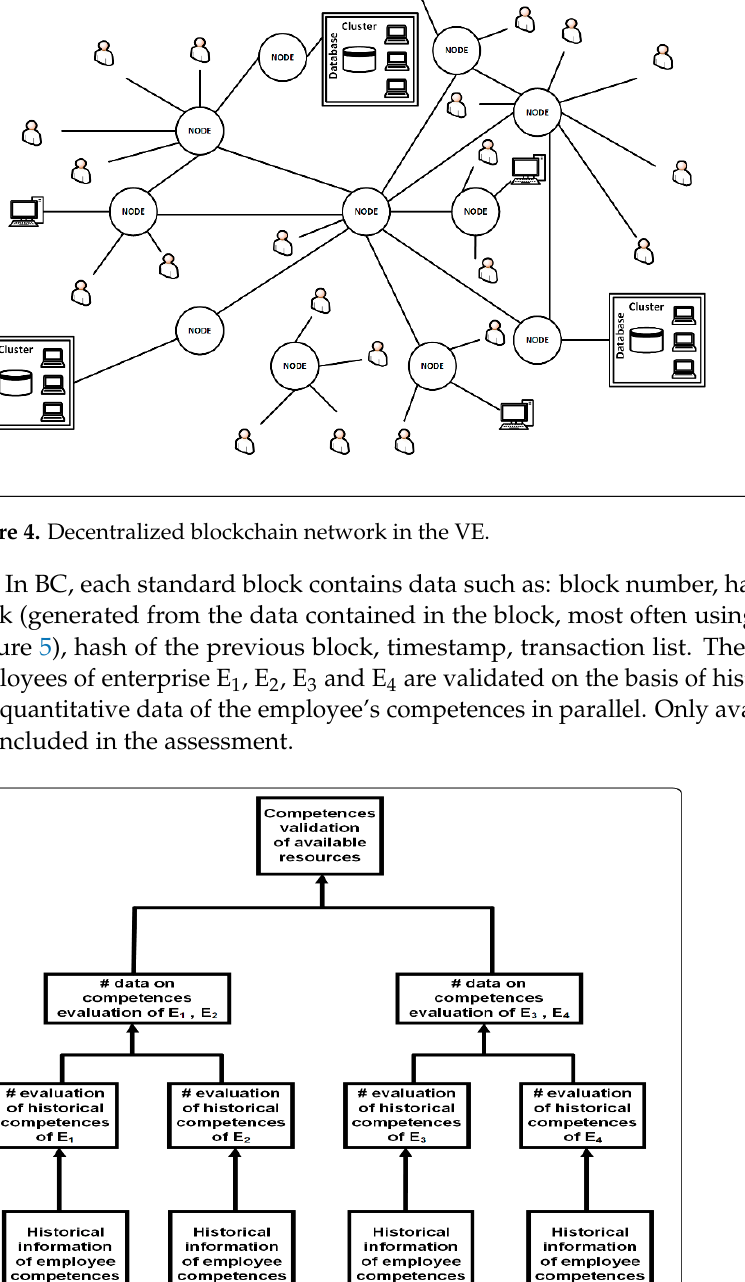
Figure 4. Decentralized blockchain network in the VE.